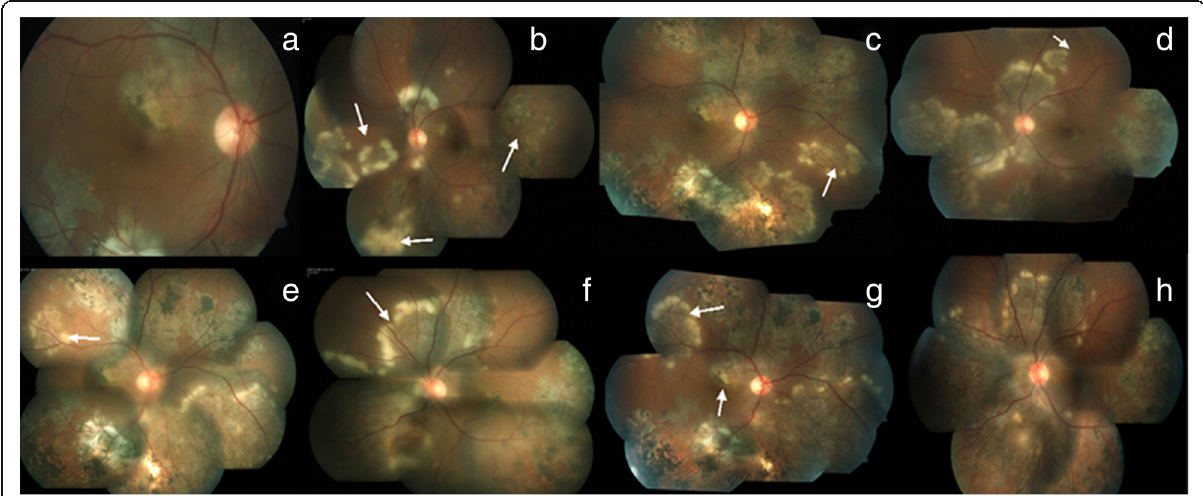
Fig. 2 a , b Fundus photograph at 3 weeks — resolving subretinal abscesses in both eyes, reactivation of serpiginous-like choroiditis in the left eye, a paradoxical reaction. c , d Fundus photograph at 4 weeks, showing formation of new lesions and progression of old lesions. e , f Fundus photograph at 6 weeks, showing relentless progression of active lesions and appearance of new lesions. g , h Fundus photograph at 10 weeks with new active lesions in the right eye involving the fovea